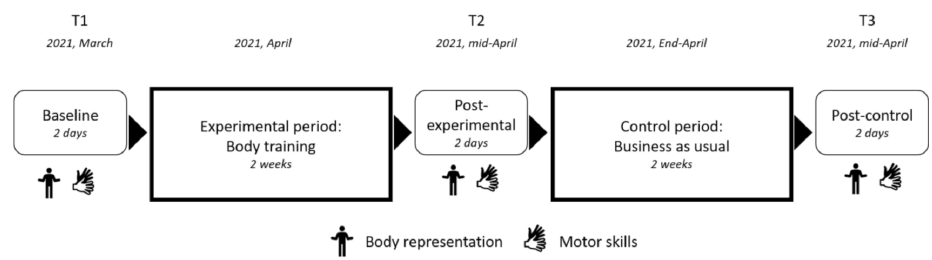
Figure 1. Illustration of the